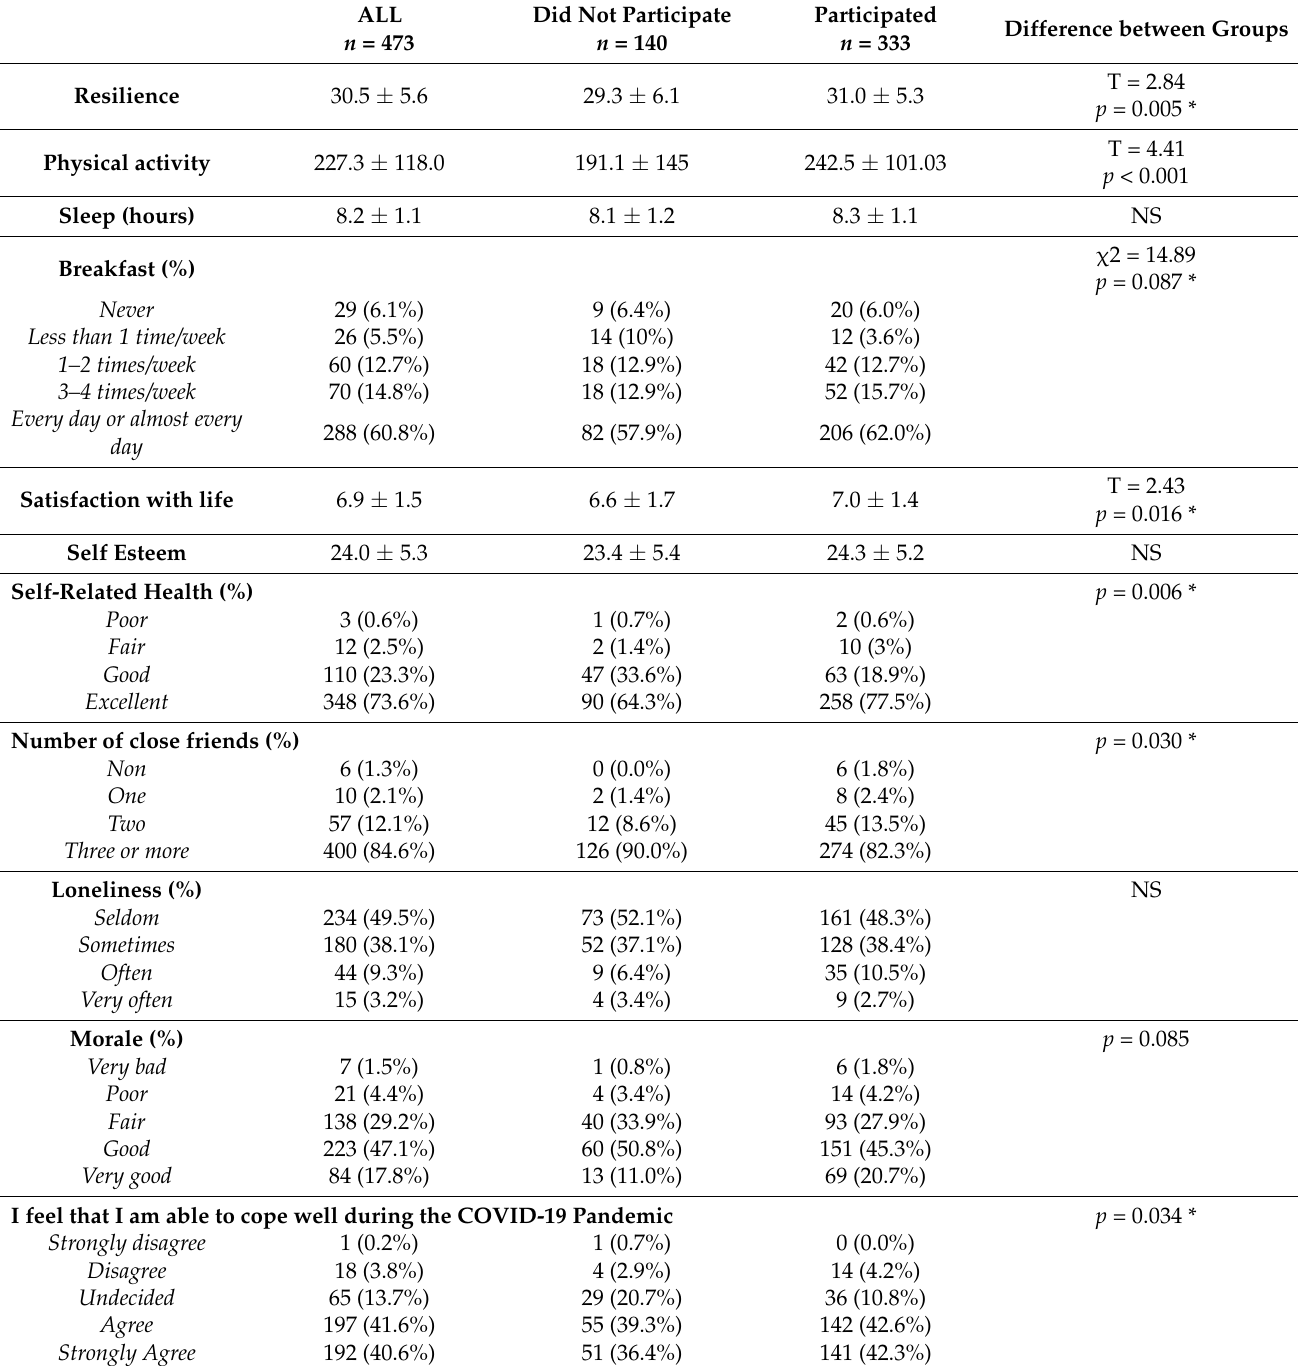
Table 2. Resilience, lifestyle, psychosocial and sports programs determinants of 473 adolescents during the COVID-19 lockdown grouped by participation in organized sports